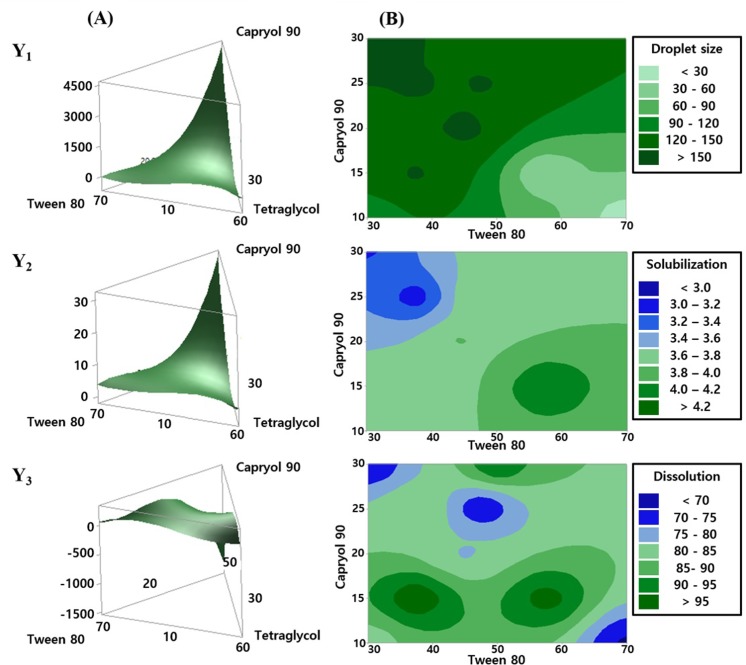
Effects of independent variables on the response factors, Y1, Y2, and Y3.(A) Three-dimensional response surface plot for the effects of the independent variables. (B) Contour plots for the effects of X1 and X2 on the responses. (Y1, droplet size (nm); Y2, TMS solubilization (mg/mL); and Y3, the percentage of drug released in 15 min (%)).